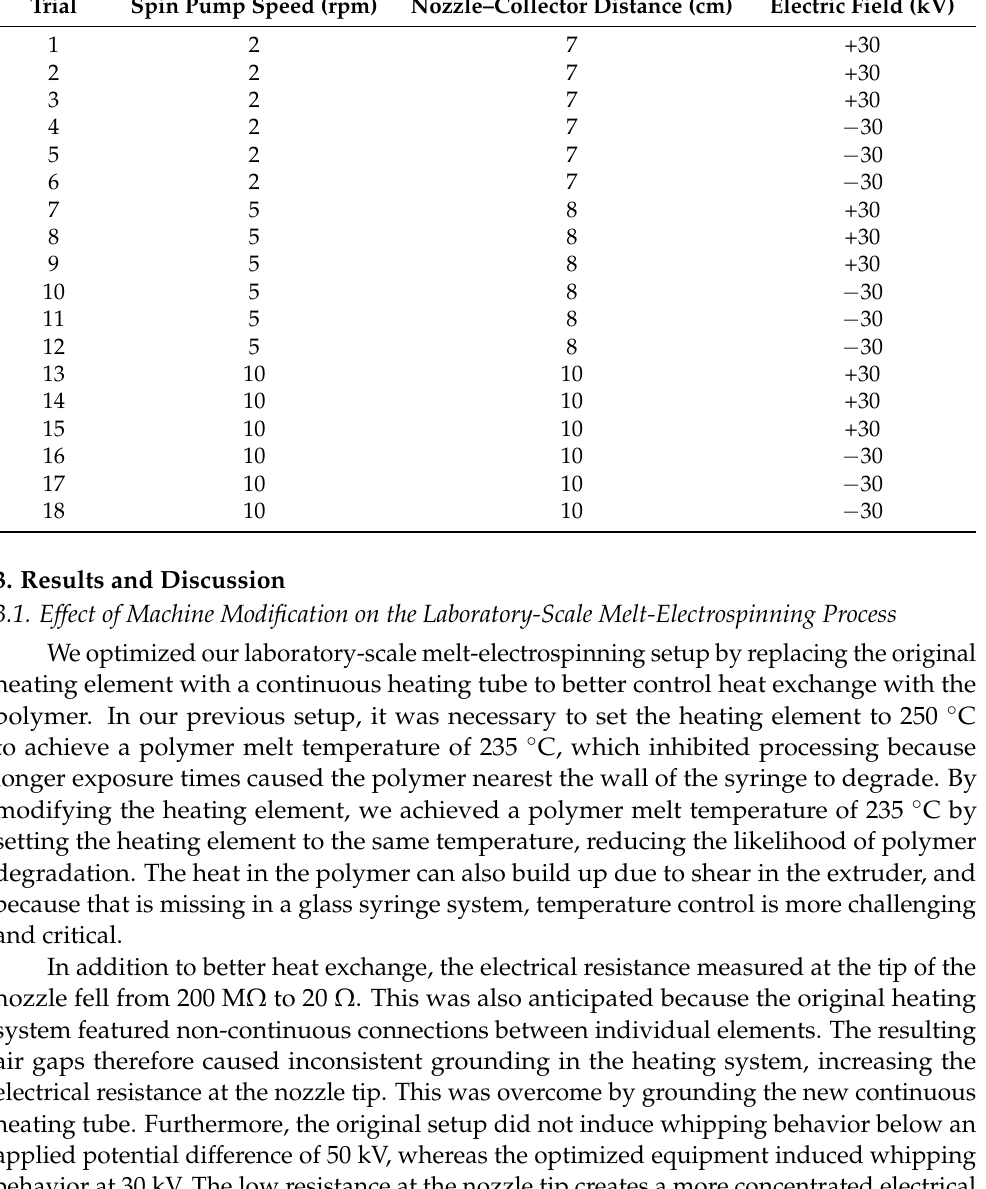
Table 2. Process parameters for the pilot-scale melt-electrospinning experiments. Trial Spin Pump Speed (rpm) Nozzle–Collector Distance (cm) Electric Field